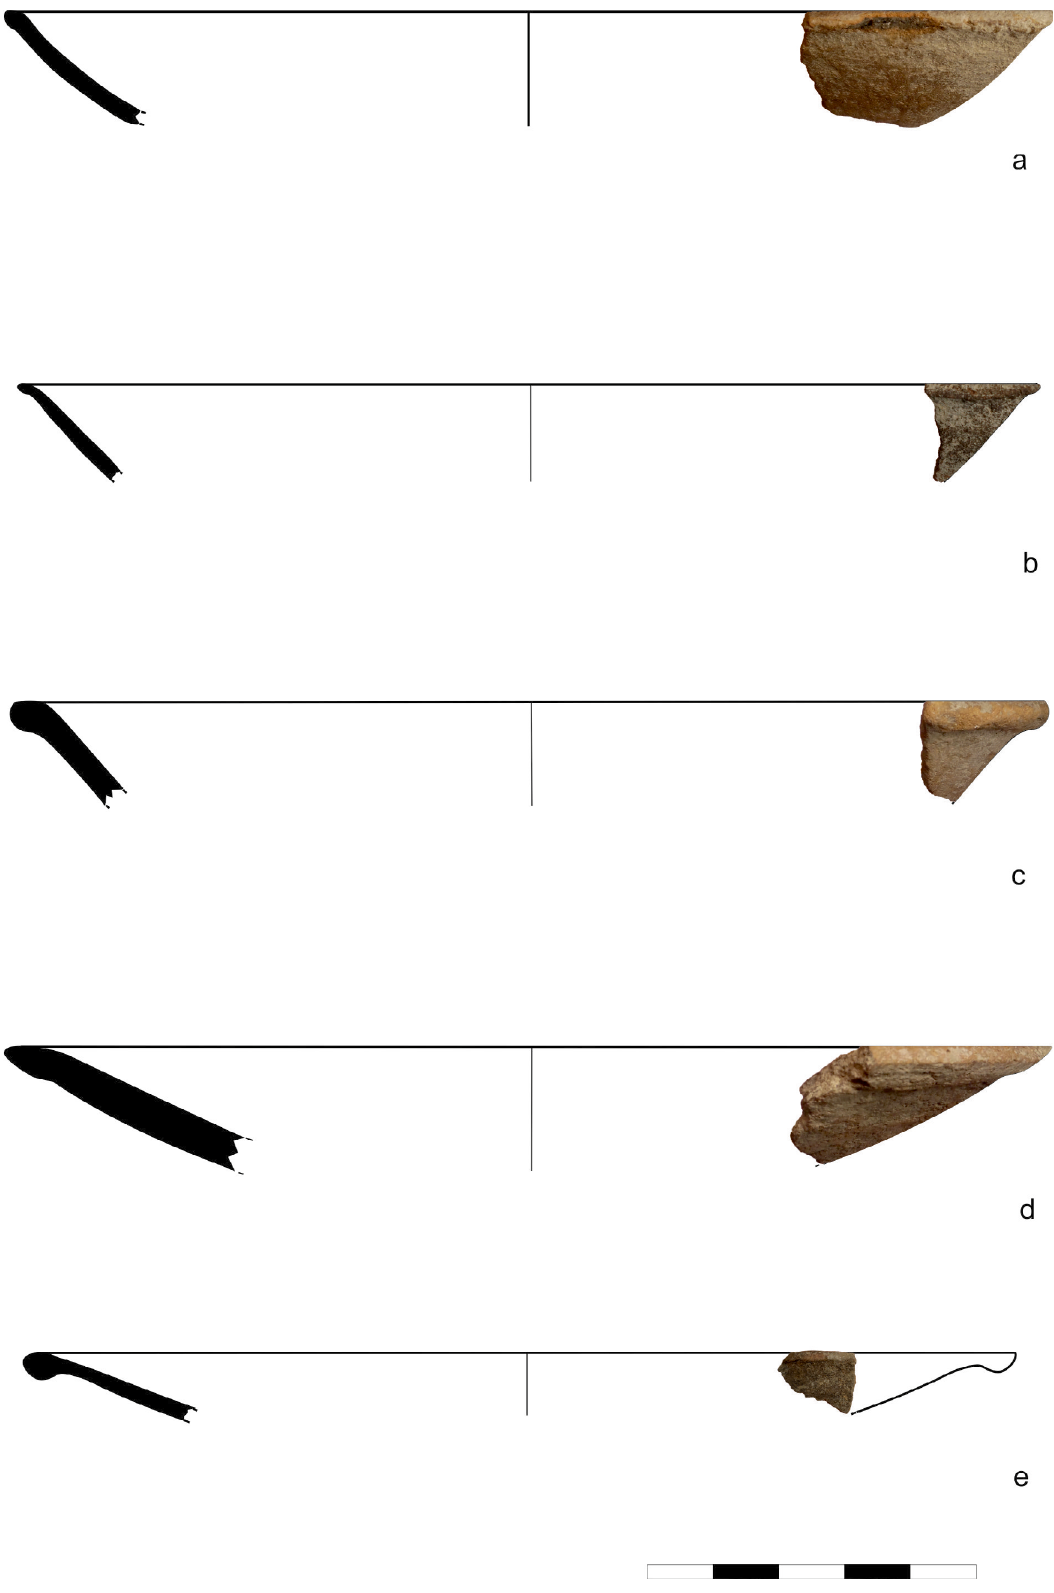
Figure 9. a-b) hemispherical pans, c-e) conical pans from